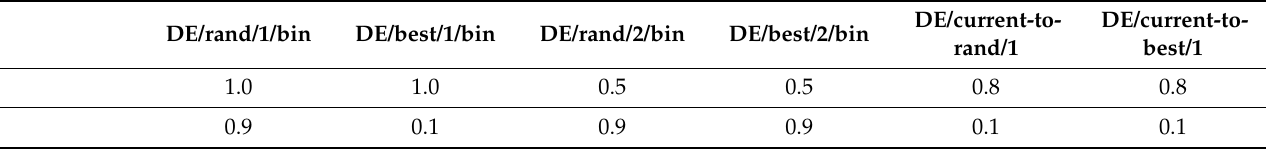
Table 1. Parameter settings for DE variants